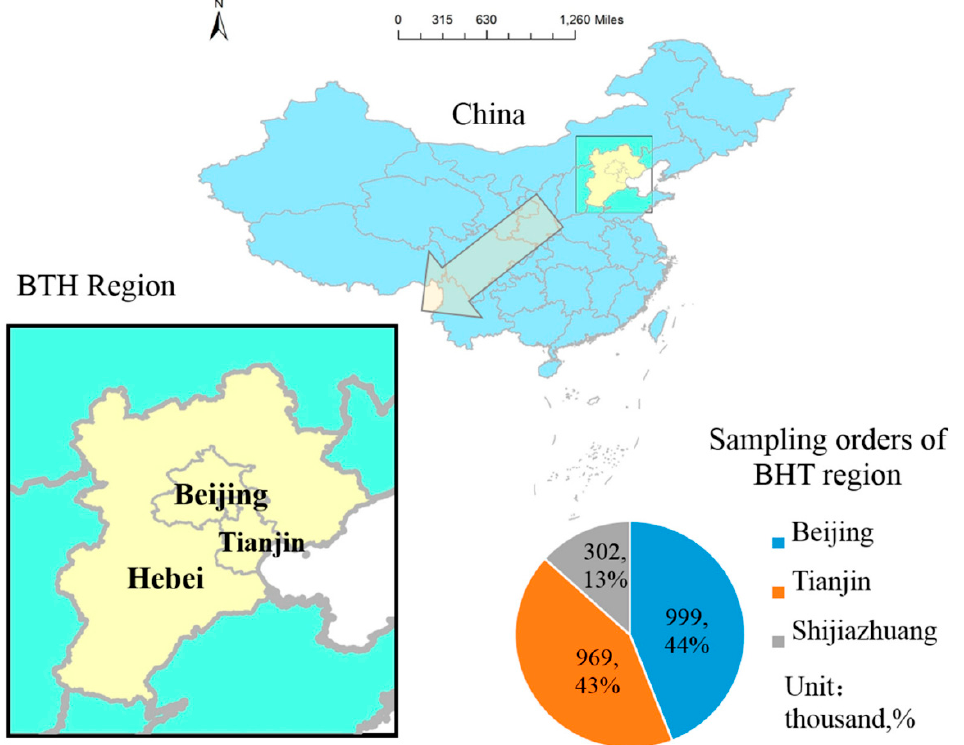
Figure 2. Research domain and sampling order in the Beijing–Tianjin–Hebei (BTH) region.